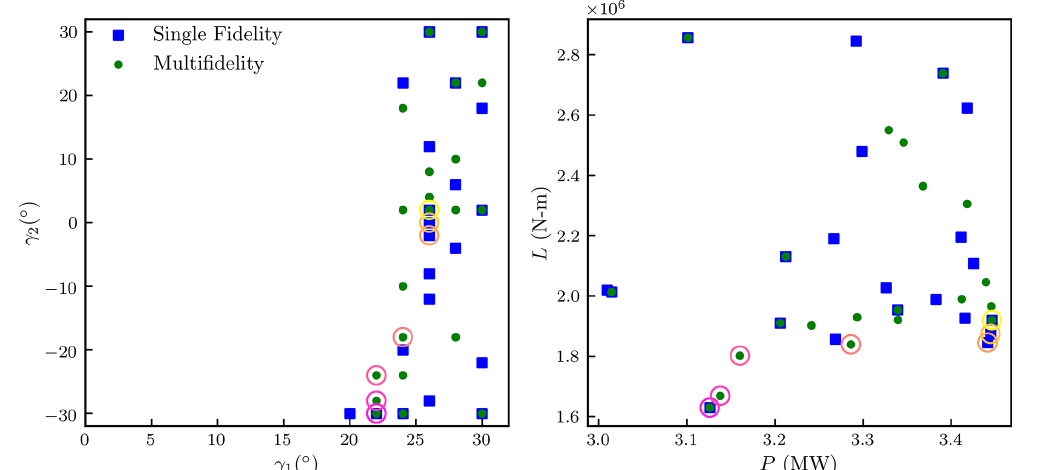
Figure 4. Sampled inputs and outputs associated with power greater than 3MW and loads less than 3MNm. Points associated with the single-fidelity approach are shown using blue square markers, and points associated with the multifidelity approach are shown using green circular markers. A Pareto set constructed from the single-fidelity and multifidelity results is highlighted with hollow circles, where darker (magenta) circles correspond to Pareto points with lower loads and lower